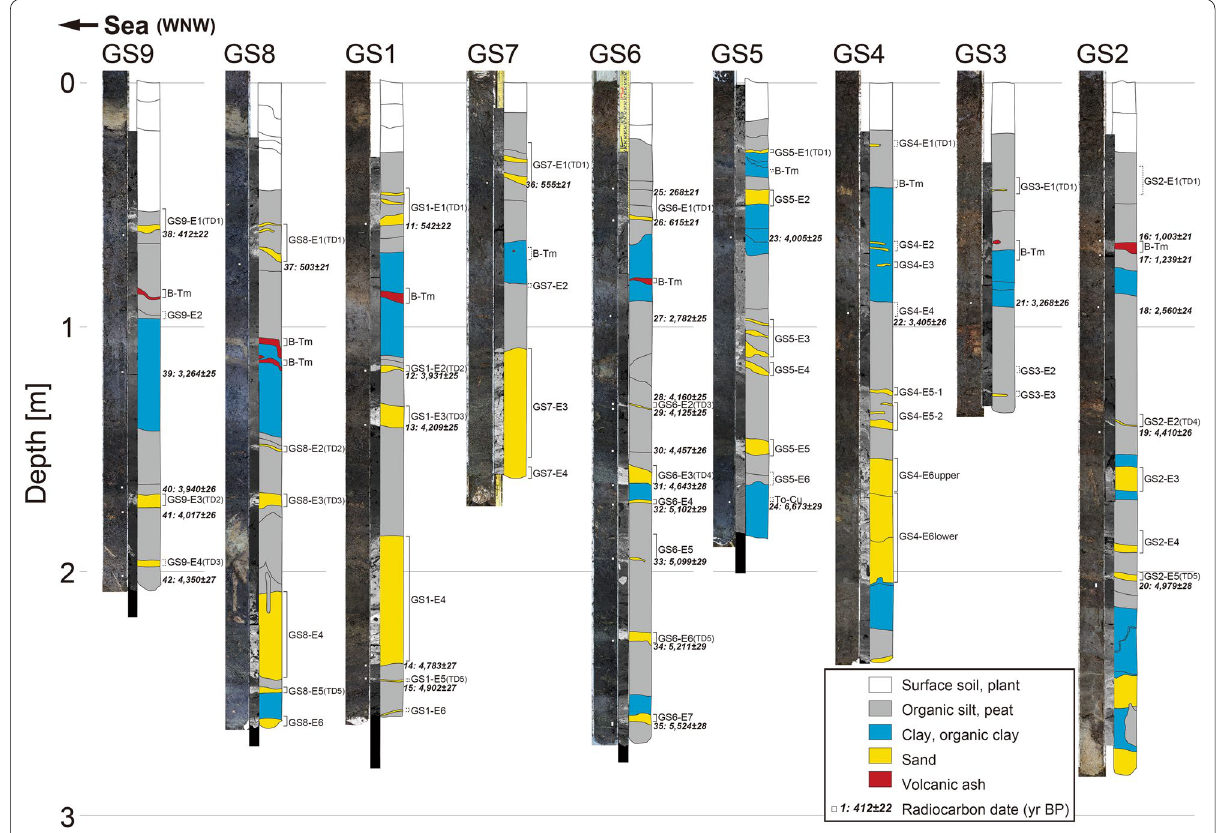
Fig. 5 Photographs, sketches, and XCT images of SKN-GS